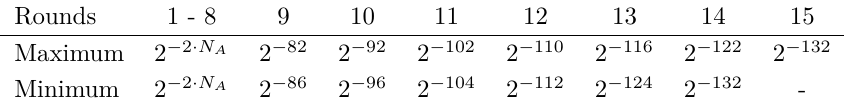
Table 9: Range of the probability of the best differential